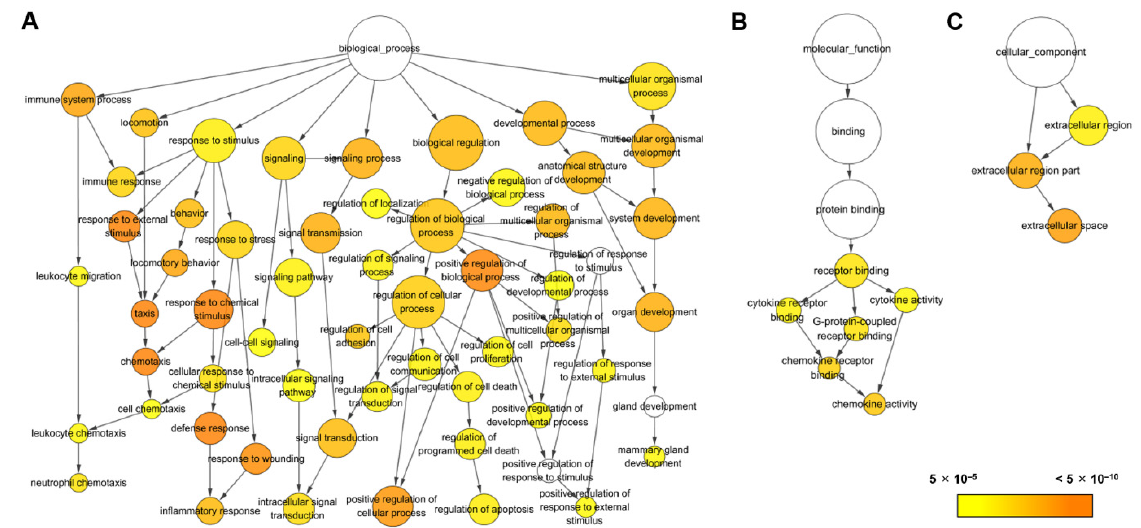
Figure 4. Gene ontology (GO) term networks of differentially expressed genes between CotG-p75 treated Caco-2 and control. Networks were generated by Cytoscape BiNGO. All significantly enriched GO terms in biological process ( A ), molecular function ( B ), and cellular component ( C ) are presented. Circle size represents GO hierarchy. Yellow shade represents enrichment level. Threshold of hypergeometric distribution of functional annotation was set at corrected p -value < 0.00005.